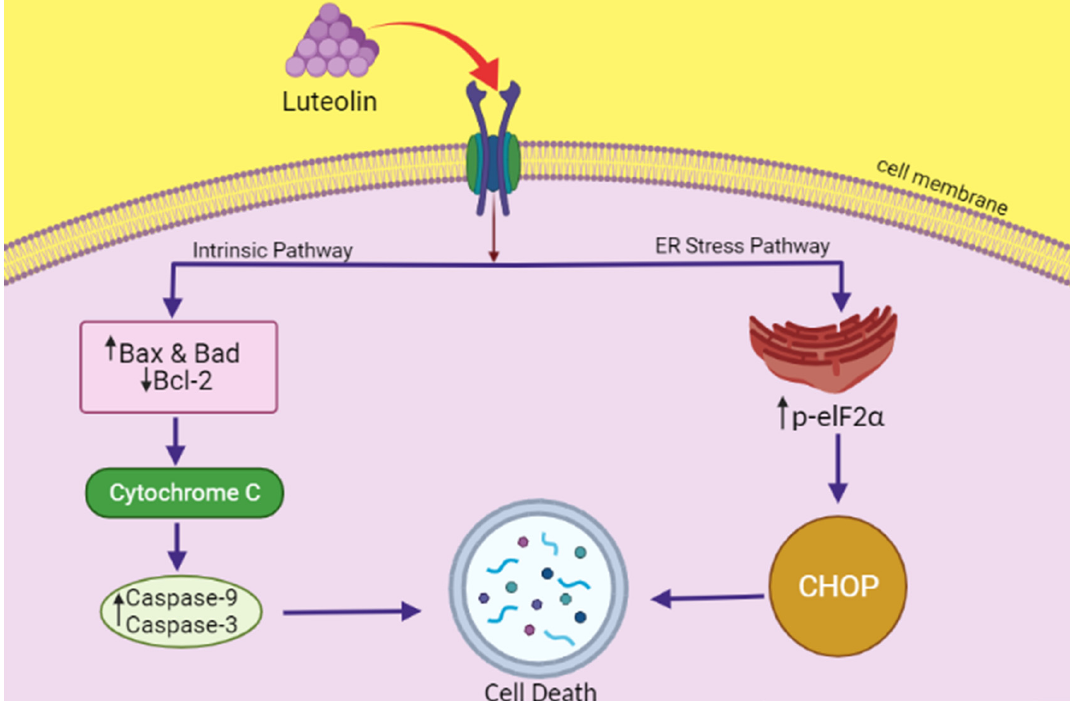
Figure 3. The schematic representation showing luteolin exerting its anticancer activity in NCI-H460 cells through the ER stress pathway. Luteolin increases ER stress expression-related proteins such as CHOP and p-eIF2 α . As the cells were treated with eIF2 α siRNA, the expression of CHOP and p-eIF2 α was remarkably reduced, which prevented the apoptotic activity of luteolin, clearly suggesting the involvement of ER stress in apoptosis after luteolin treatment. Luteolin also stimulates Bax, Bad, and Bcl2, in turn activating caspase-3 and 9, leading to apoptosis (cell death). In yet another study, Lee et al. showed that luteolin exerts apoptotic activity in hepatocellular carcinoma cells via ER stress-activated p53 and decreases the number of cells. p53 is a tumor protein that functions to suppress gene mutations and thus prevent tumor formation. These authors evaluated two types of cells, p53-wild and p53-null cells, to establish whether ER stress is a relevant target for suppressing the growth of hepato- cellular cancer with luteolin. The immunoblotting and PCR carried out on both types of cells revealed that the p53-nullcells showed significant catalase downregulation and mRNA upregulation. This meant that there was respectively an induction of oxidative stress and ER stress in luteolin-treated cells [145]. 7.1. Anticancer Mechanism of Luteolin, Combating ER Stress Luteolin is a flavonoid that has been shown by numerous researchers to induce cy- totoxicity in several types of cancer, such as breast, lung, colon, liver, pancreatic, brain, kidney, prostate, ovarian, skin, oral cancers, etc. It has been reported to exert its anti- cancer action by inhibiting the proliferation of cancer cells, raising the amount of ROS, inhibiting carcinogenic stimulation, and by bringing about cell death through ER stress [29]. Luteolin acts on multiple signaling pathways in different cancers that mediate the